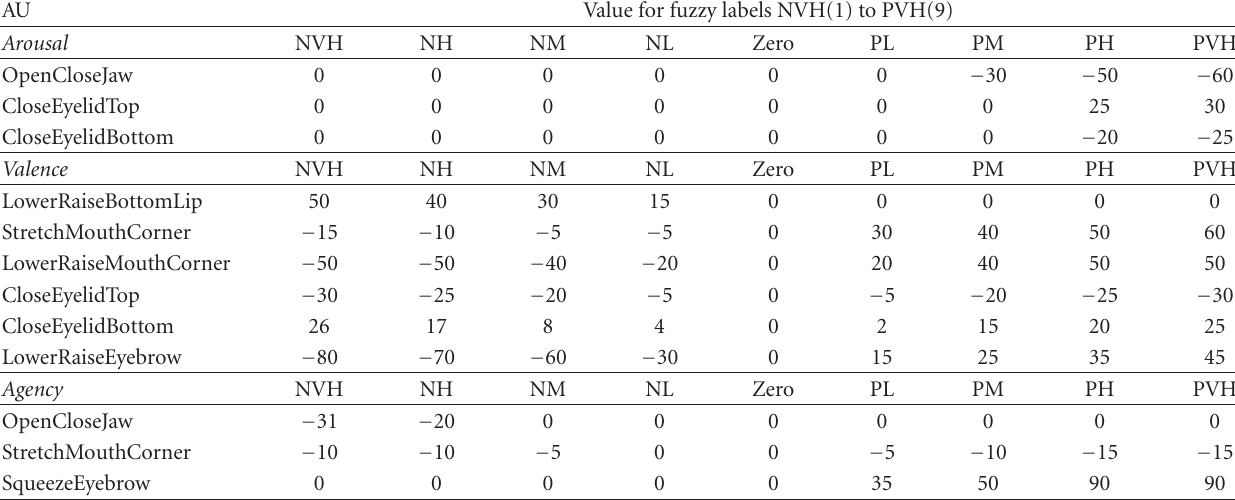
Table 6: Fuzzy rules for activating facial